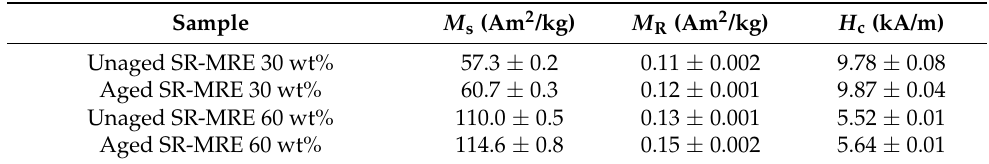
Figure 2. The magnetic properties of unaged and aged SR-MRE samples with different concentrations of CIPs. Table 1. The summary of magnetic properties of unaged and aged SR-MRE samples (30 and 60 wt% of CIPs) samples.